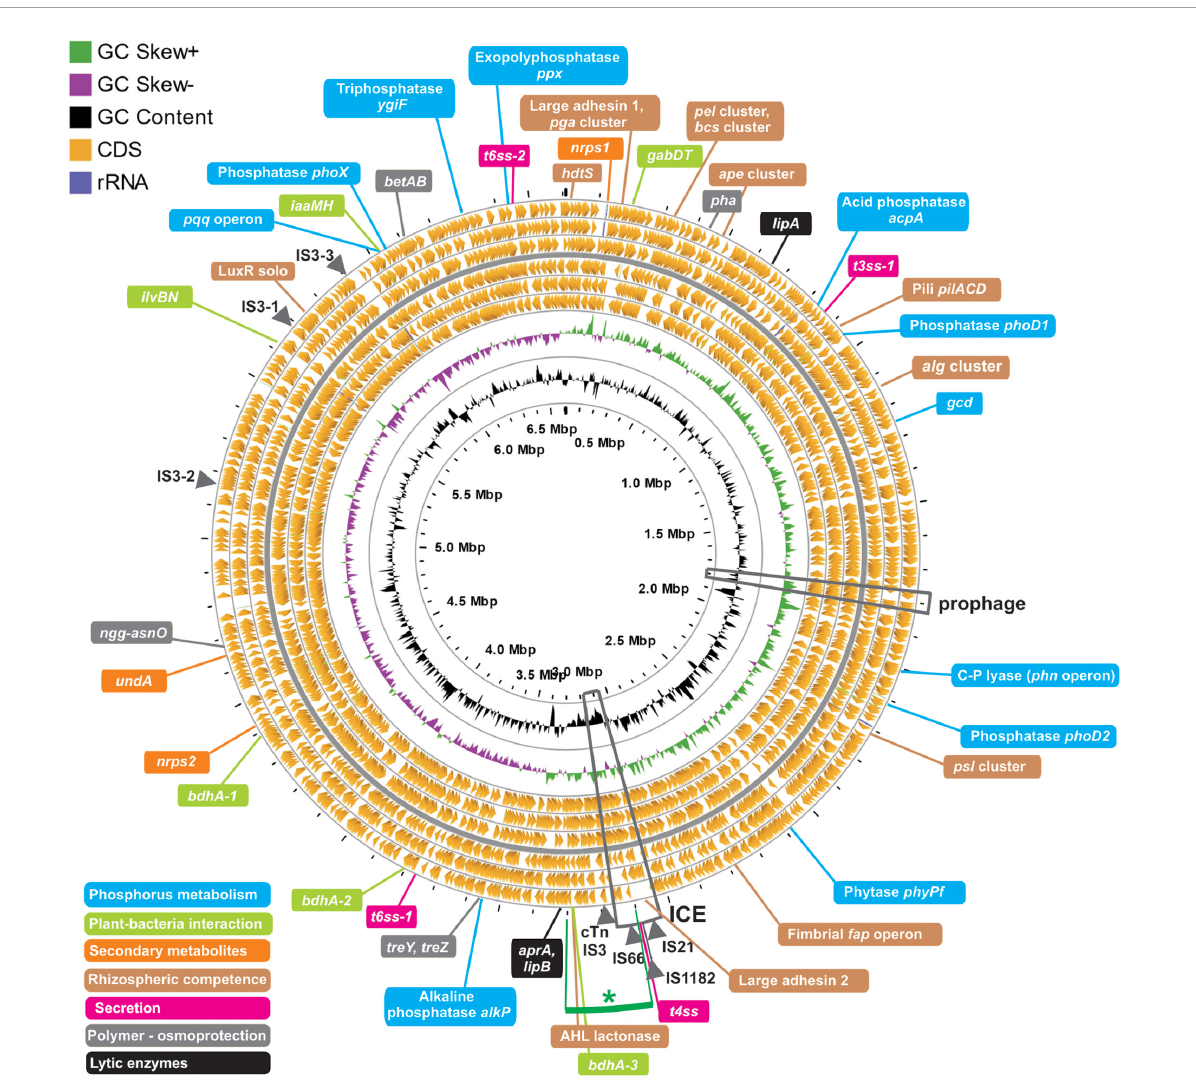
FIGURE3 Characteristics and features of the genome of Pseudomonas sp. strain 1008. The circular map of the 6.6 Mb chromosome was performed with the GCview server (http://cgview.ca/). The circles represent, from outside to inside: rings 1–6, protein coding genes in the three different reading frames, oriented in the forward (rings 1–3) and reverse (rings 4–6) orientations, respectively. Ring 7 shows GC skews, with positive and negative values being indicated with green and purple colors, respectively. Ring 8 shows G + C% content plot (black). The innermost ring indicates absolute chromosome coordinates. Positions of mobile genetic elements are indicated with arrowheads in the outermost ring. The location of an intact prophage and of an integrative and conjugative element (ICE) are indicated with boxes. Finally, the position of a number of genetic loci related to plant growth promotion and rhizosphere competitiveness are indicated with colored lines, following the reference colors of the legend positioned at the lower left